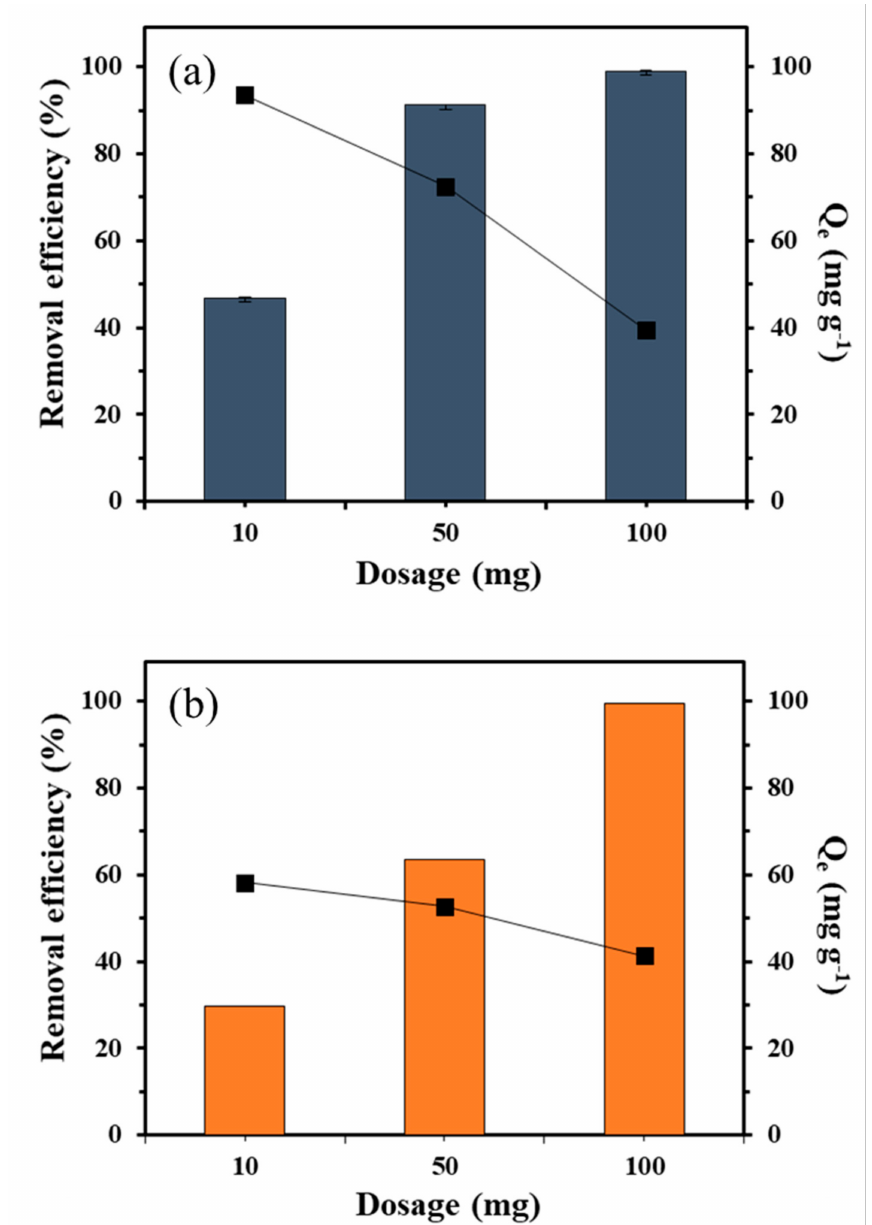
Figure 5. Effect of adsorbent dosage on TC adsorption by ( a ) UiO-66 and ( b ) UiO-66-NH 2